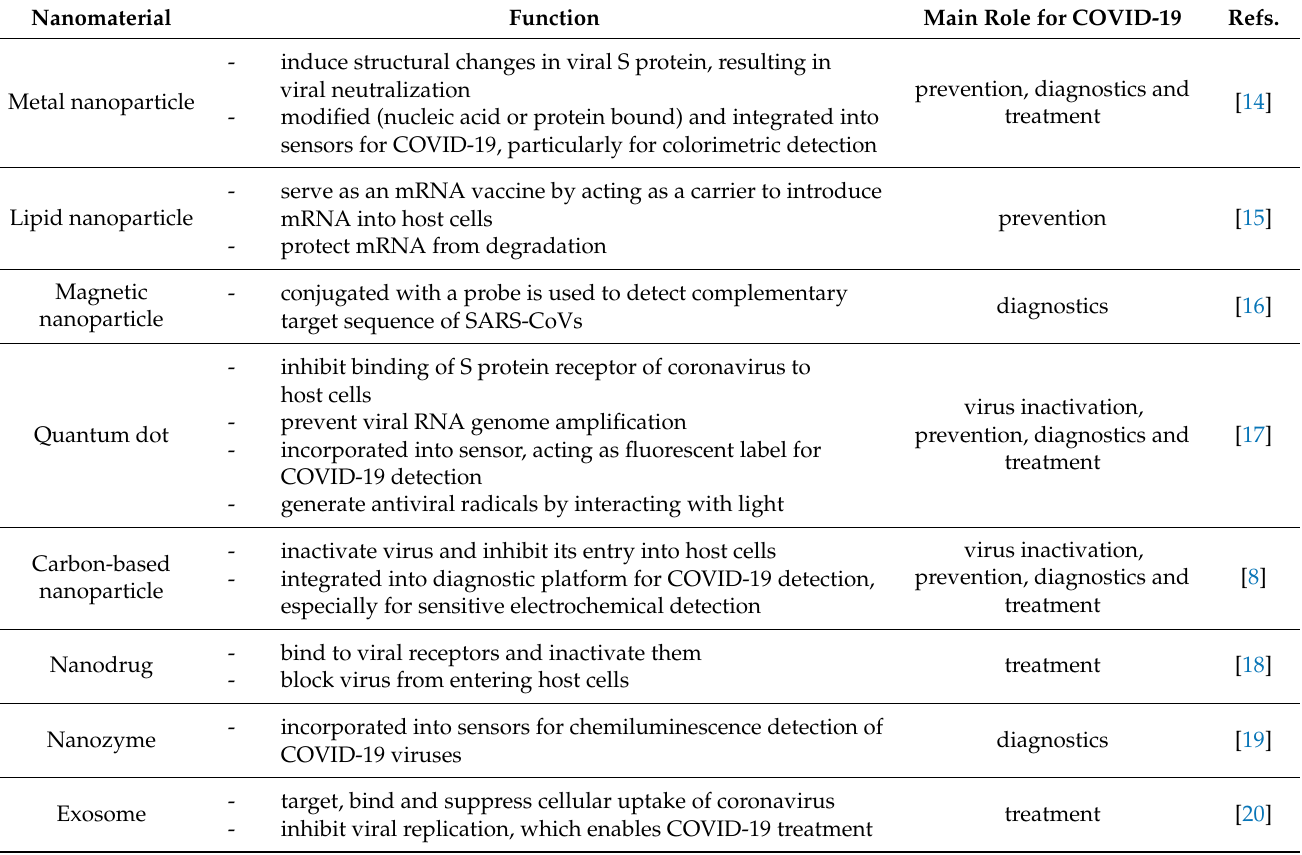
Table 1. Summary of the role of nanomaterials for COVID-19.